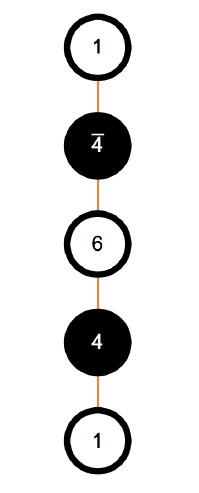
Figure 13 . Adynkra Diagram for 6D (1 , 0) Multiplet.